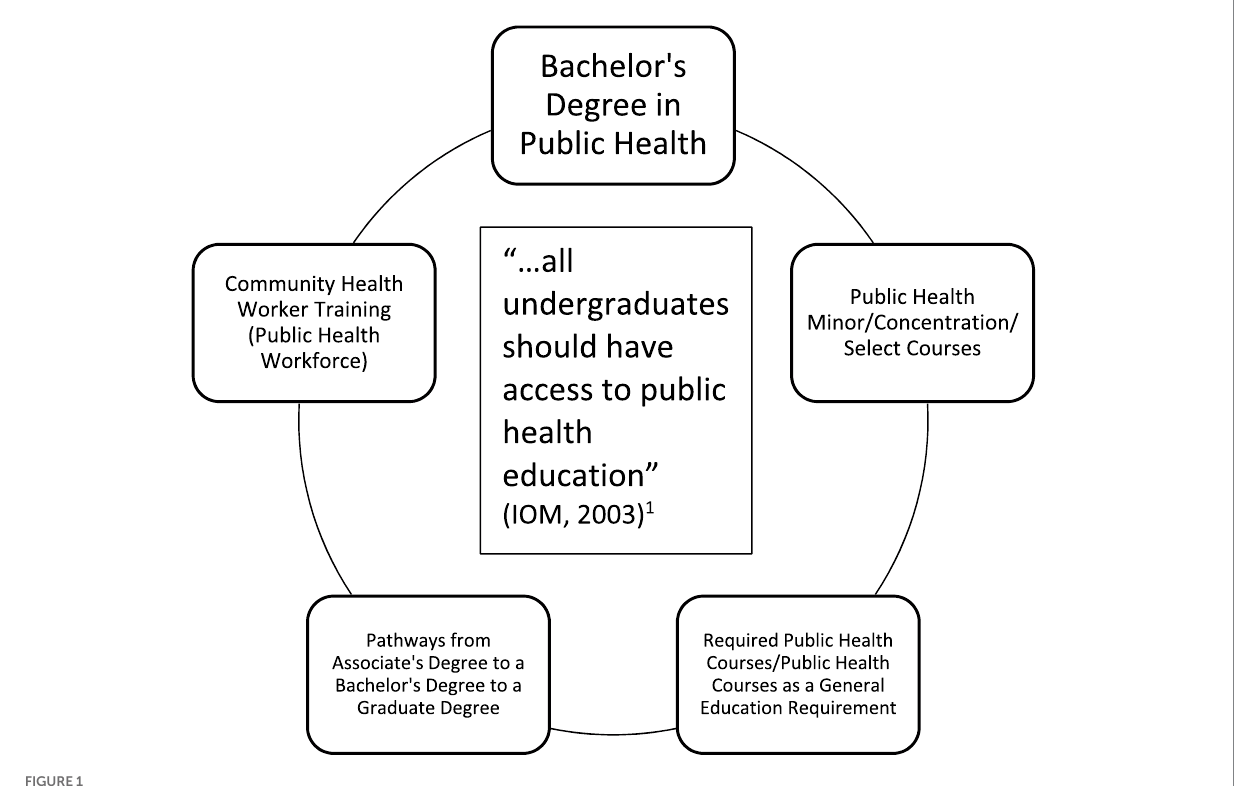
FIGURE 1 Types of public health education at select 2- and 4-year U.S. academic institutions